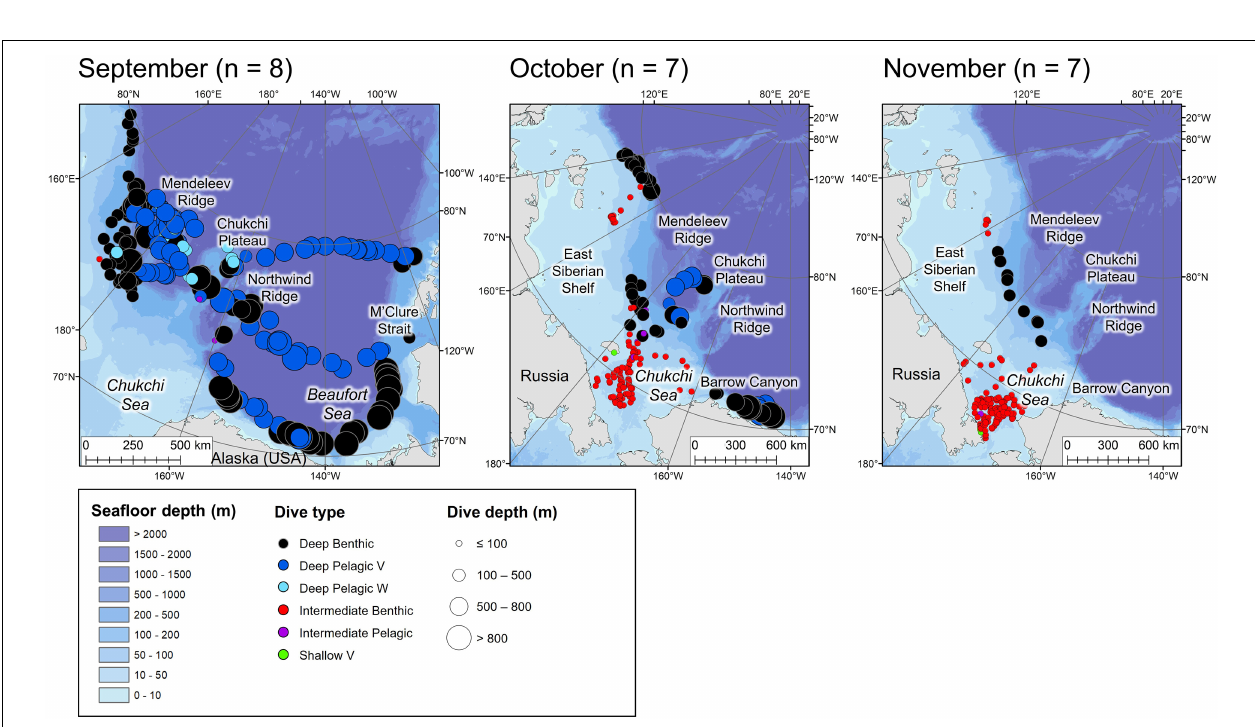
FIGURE 4 | Locations of the daily deepest dive made by each beluga during the fall months. Symbol color represents dive type and symbol size represents the maximum depth reached. n in parentheses gives the number of belugas which transmitted data in the given month.